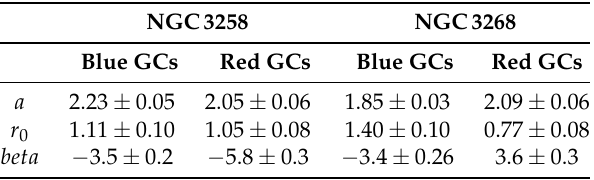
Table 2. Parameters of the modified Hubble distribution fitted to the FORS1 radial profiles.